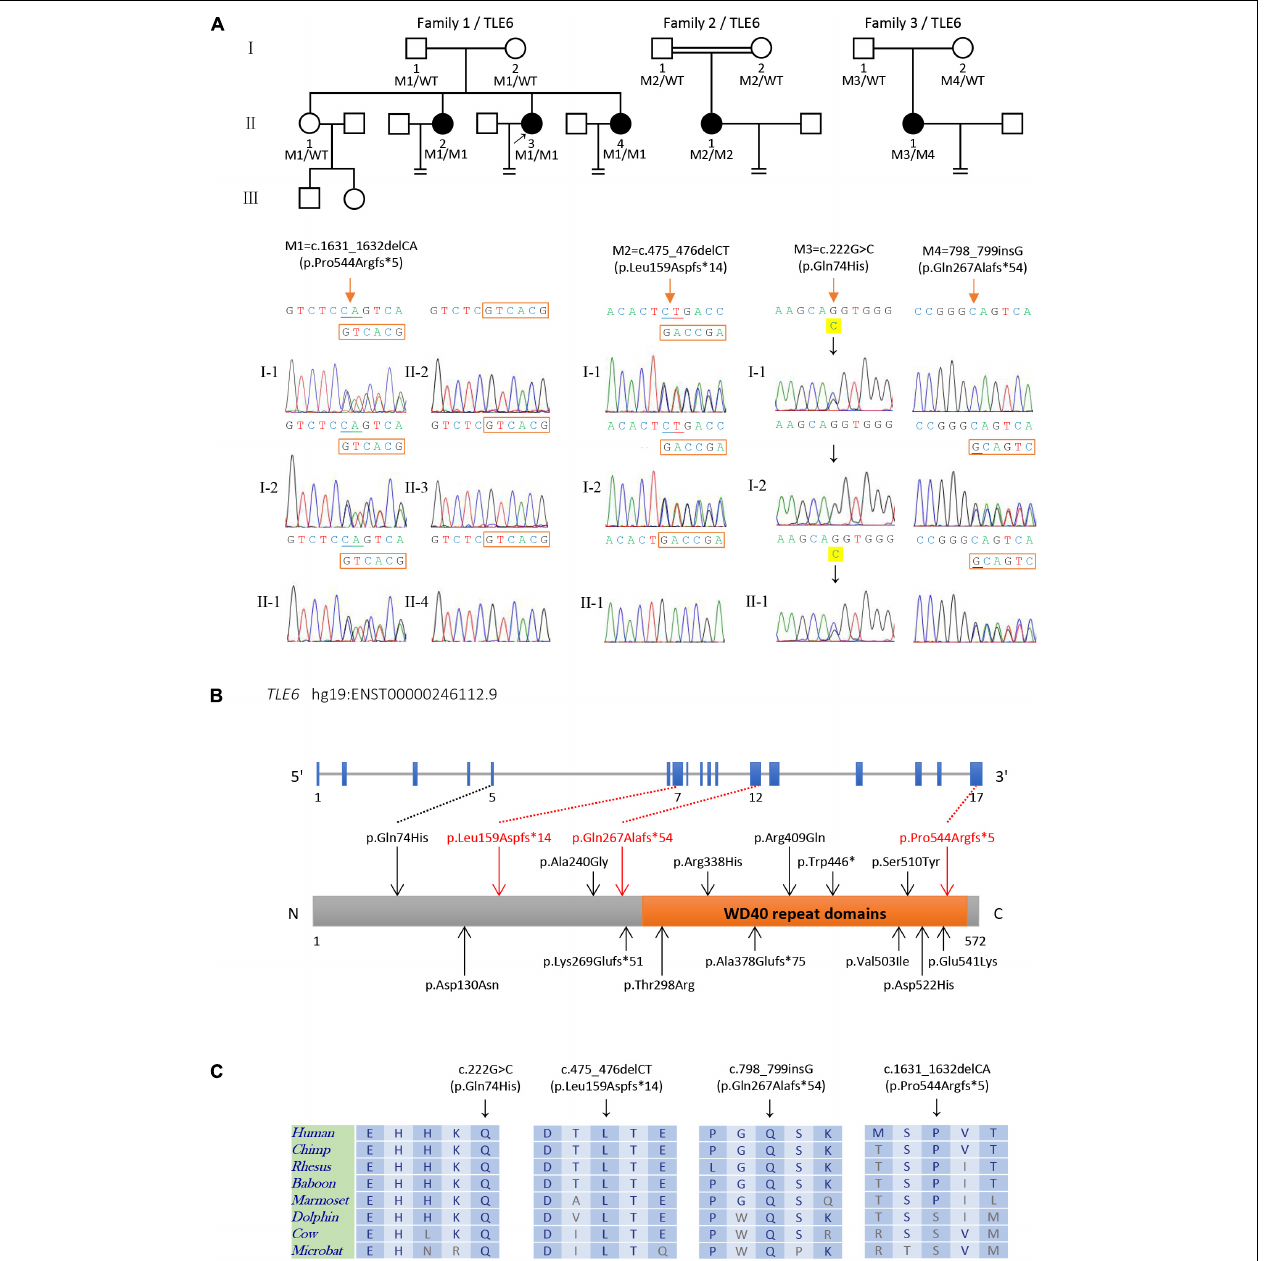
FIGURE 1 | Identification of biallelic TLE6 variants in the patients and their family members. (A) Pedigrees structure of three families harboring variants in TLE6 , circles represent female patients, squares represent male patients, and black circles denote patients with primary infertility. The double line represents consanguinity, equal signs indicate infertility, and the arrow indicates the proband. Sanger sequencing verification is shown below the pedigrees. Red arrows indicate the mutated positions. (B) Schematic representation of the TLE6 gene and domain structure of its protein product. Black arrows indicate previously reported variants, while red arrows represent the novel variants identified in this study. Orange box represents a cluster of seven WD40 domain repeats. (C) Sequence alignment displays conservation of mutant residues in TLE6 among different